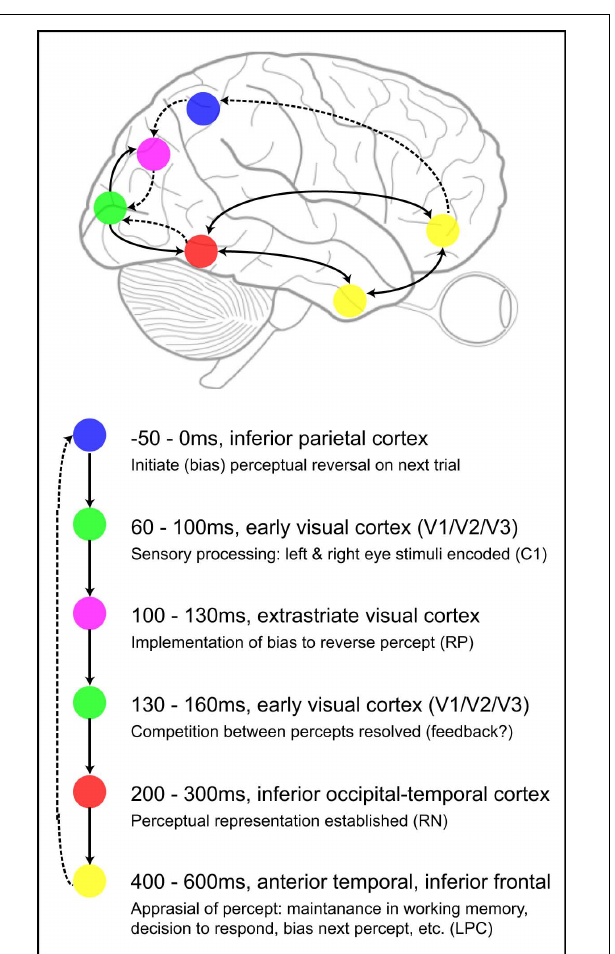
FIGURE 2 | Neural model of the sequence of brain events in which EEG differences have been found during binocular rivalry. Solid one-way arrows indicate hypothesized feed-forward pathways, dashed one-way arrows denote feedback connections, and double-sided arrows indicate possible wide-spread recurrent interactions between distant brain regions. Timing information, estimated neural generators locations, and proposed functional contributions are listed in order of occurrence. Names of associated ERP components are provided after each hypothesized function (where